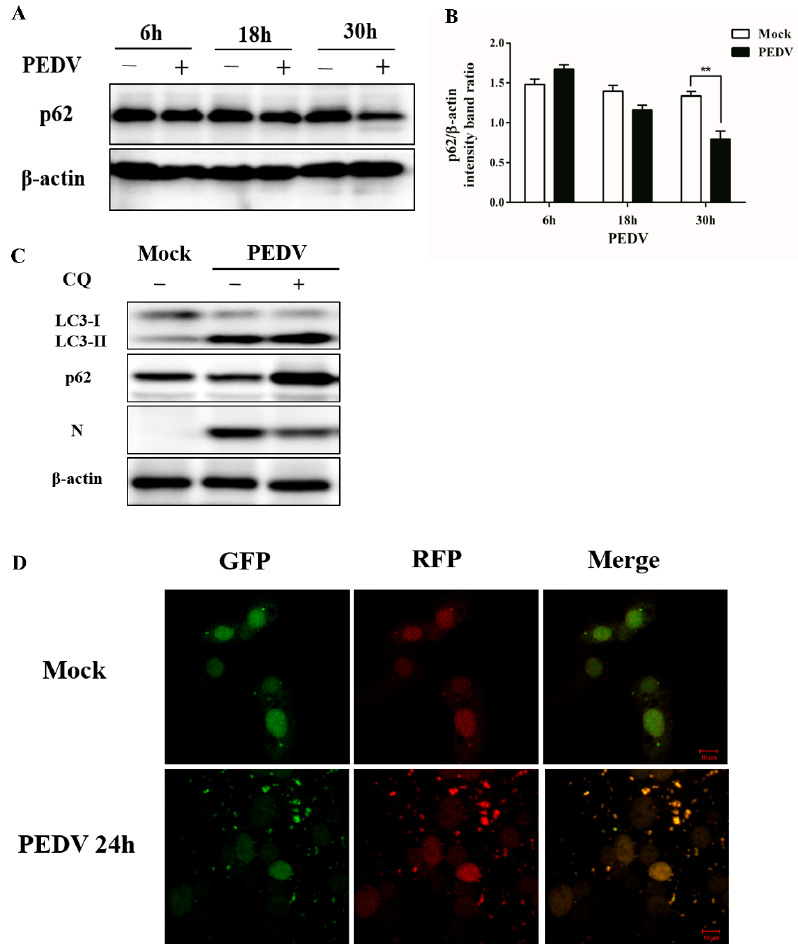
Figure 3. PEDV infection enhances autophagy flux. ( A ) Vero cells were mock-infected or infected with PEDV (0.1 MOI) for 6, 18, and 30 h. The cells were then analyzed by Western blot with antibodies against p62 and β -actin, separately. ( B ) The intensity band ratio of p62 to β -actin was analyzed by using ImageJ software. The data were presented as mean ± SEM of three independent experiments ( t -test, * p < 0.05, ** p < 0.01, *** p < 0.001). ( C ) Vero cells were pretreated with CQ (50 µ m) for 4 h, prior to PEDV (0.1 MOI) infection. After PEDV adsorption for 1 h, the cells were further cultured in fresh medium in the absence or presence of CQ. At 24 hpi, cell samples were detected by Western blot with antibodies against LC3, p62, N, and β -actin. ( D ) Vero cells were transfected with mRFP-GFP-LC3. Twenty-four hours later, the cells were mock-infected or infected with PEDV (0.1 MOI), then collected and visualized at 24 hpi, respectively. Scale bar, 10 µ